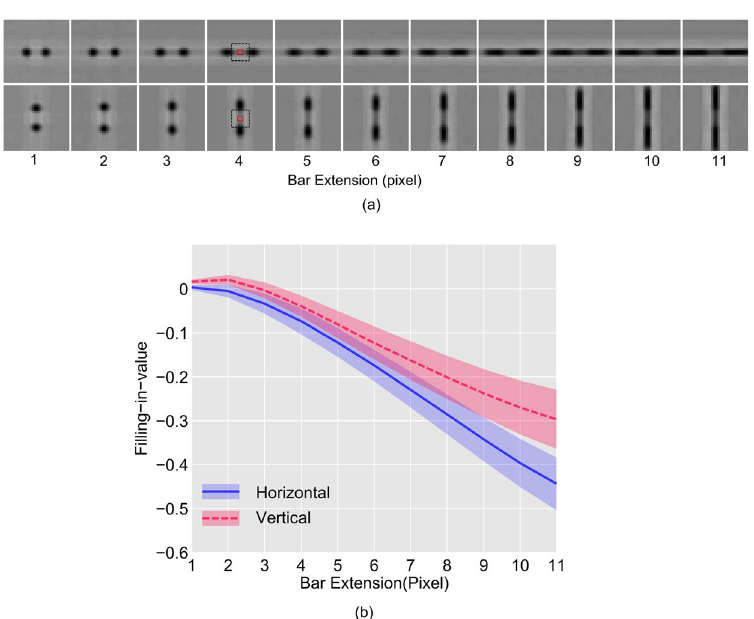
Figure 4. Anisotropy in filling-in. ( a ) Perceptually equivalent images are shown, which are generated from the response of PE neurons while the network was stimulated with stimuli depicted in Fig. 3a. The dotted black square (in the fourth column) indicates the position of the blind spot and the red square indicates the area (2 × 2 pixel) from where the average filling-in-value is obtained. The same convention is followed for all the images. ( b ) The plots of ‘filling-in-value’ in BS area of the images in ( a ) are shown as a function of bar extension measured from the edge of the blind spot. The lines represent the average, and the shaded portion indicates the standard deviation for the 40 training